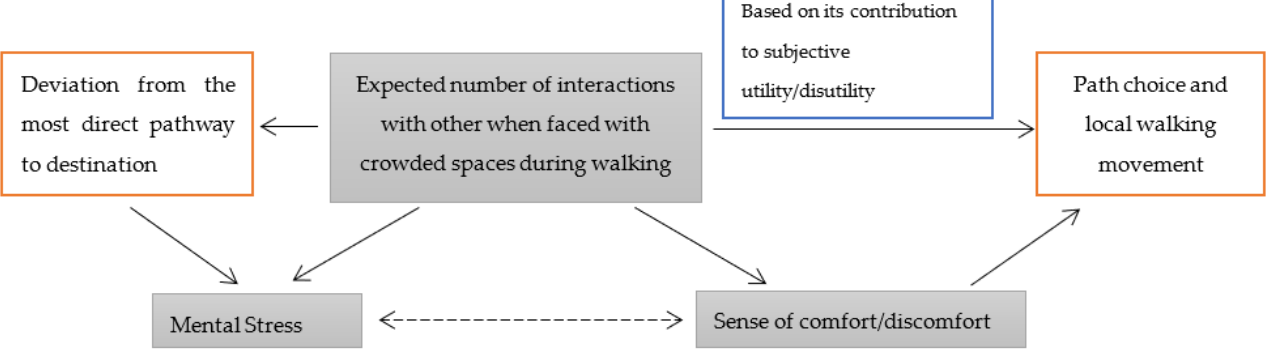
Figure 3. The process of intervention of sense of comfort/discomfort to stress and walking movement while encountering with crowded spaces during walking in this pandemic.